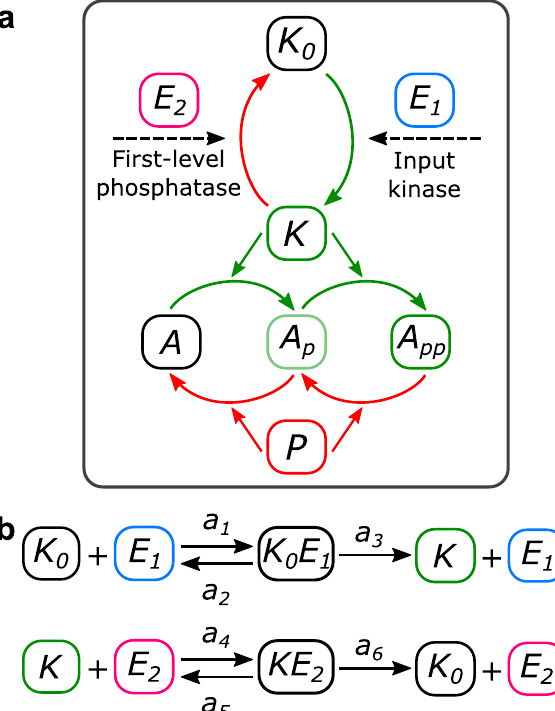
Figure 5. Scheme of the 1 + 2 system and its enzymatic first-level reactions. ( a ) Scheme of the model, with the kinase E 1 and phosphatase E 2 involved in the first-level reactions standing in contrast to the SK activation module. ( b ) Reactions for the activation and inactivation of the first-level kinase, involving intermediate complexes with E 1 and E 2